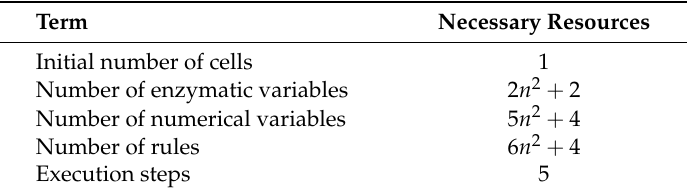
Table 1. Complexity and resources needed for